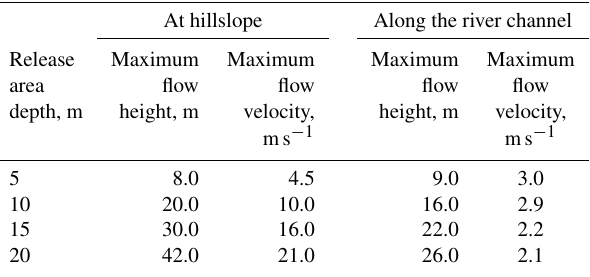
Table 3. Results of the runout simulation at different depths of the release area. At hillslope Along the river channel Release Maximum